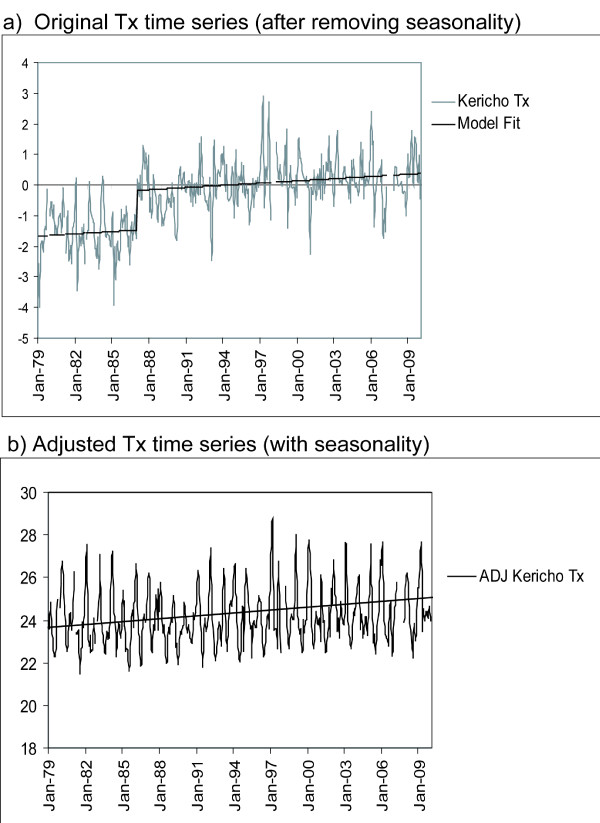
Time series of monthly values of Tx after removing seasonality (i.e., the 30-year mean values shown in Figure 1) (deg. C) for a) original data, also showing model fit, and b) adjusted data after removing an identified break-point and including seasonality. The linear trend for the full data period is shown by the solid line (see Table 1 for slope and significance).